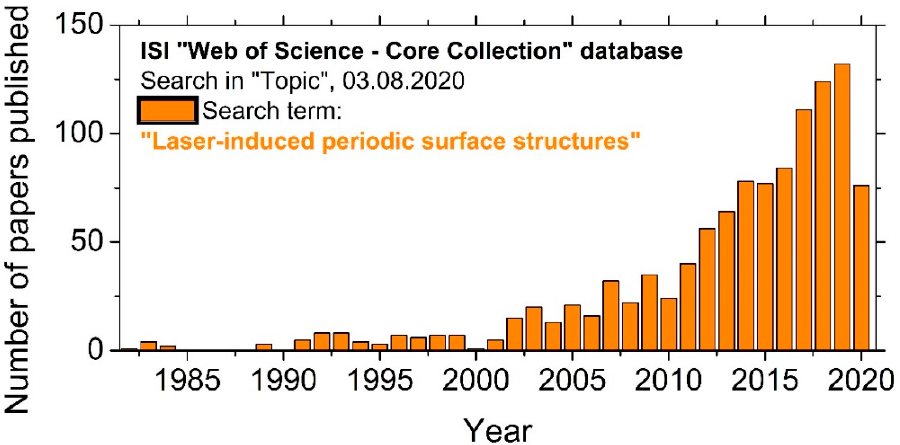
Figure 2. Research activities in the area of LIPSS, exemplified by the number of papers published per year—matching on 3 August 2020 in the “ISI Web of Science—Core Collection” database to the search term “Laser-induced Periodic Surface Structures”.